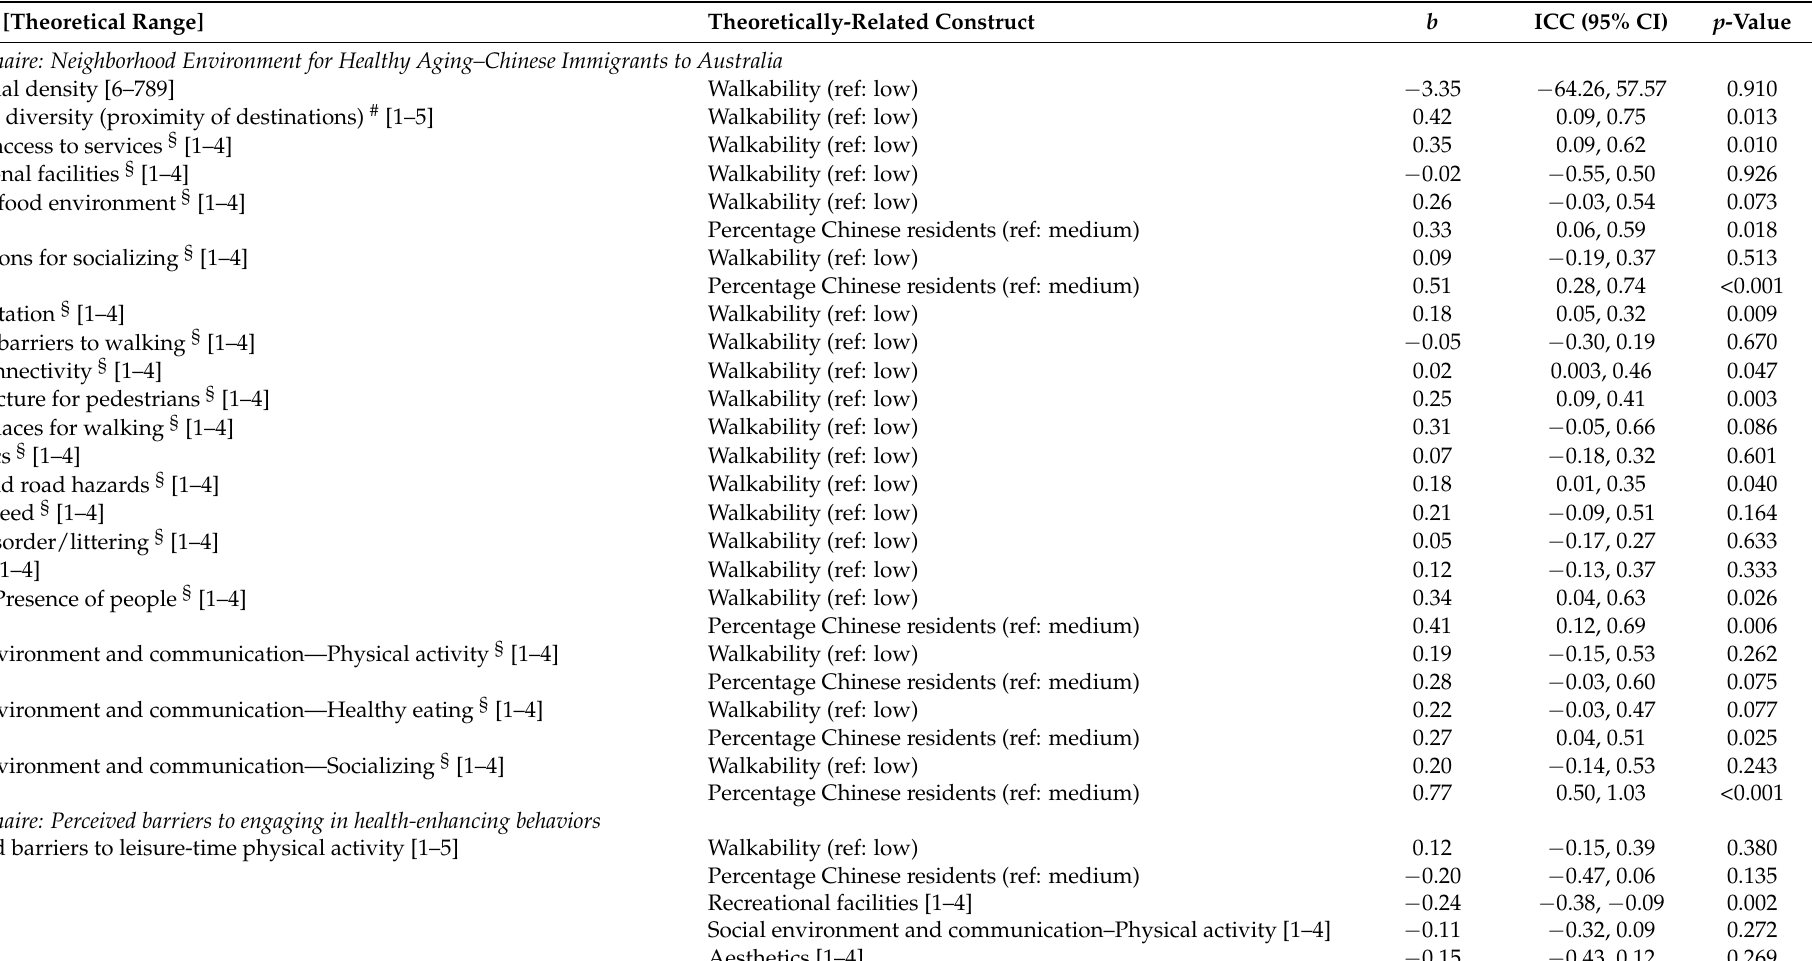
Table 6. Associations of measures of perceived neighborhood environmental attributes influencing, and perceived barriers to engagement in, healthy behaviors for older Chinese immigrants to Australia with theoretically-related constructs: construct validity